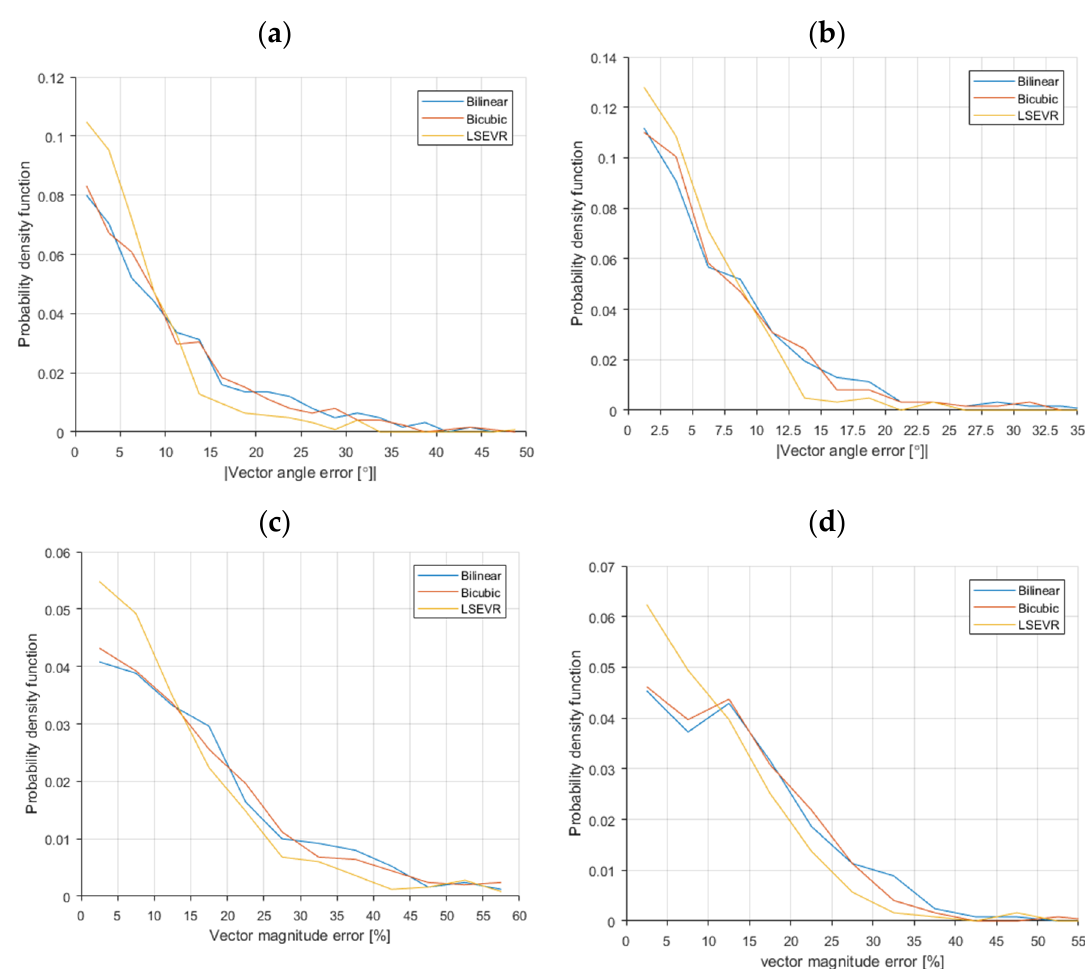
Figure 13. Probability density functions (PDF) of errors for each technique. ( a , b ) present the PDFs for absolute vector angle for all replaced vectors and those non-near zero respectively. ( c , d ) present the PDFs for vector magnitude error for all replaced vectors and non-near zero respectively.